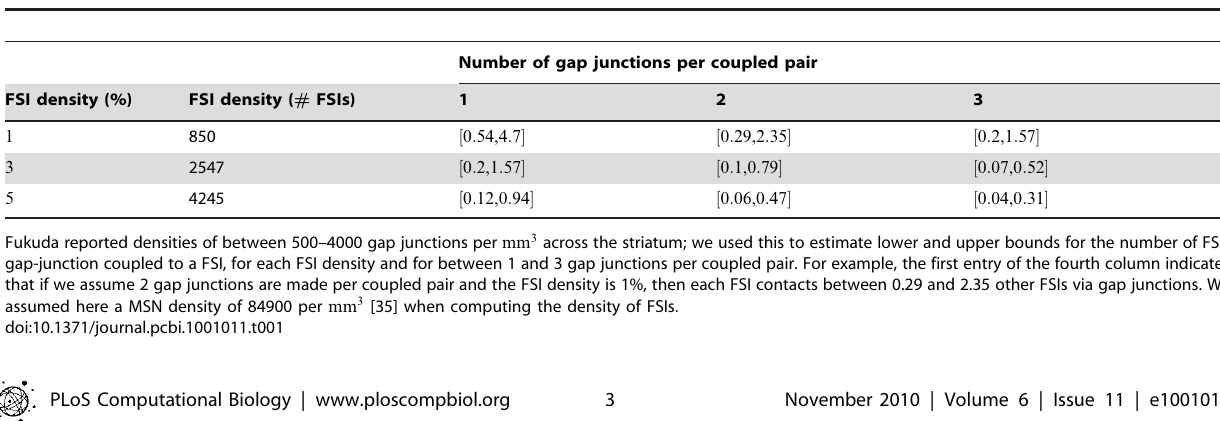
Table 1. Estimates of the mean number of FSIs gap-junction coupled to each FSI, derived from Fukuda’s [39] data.